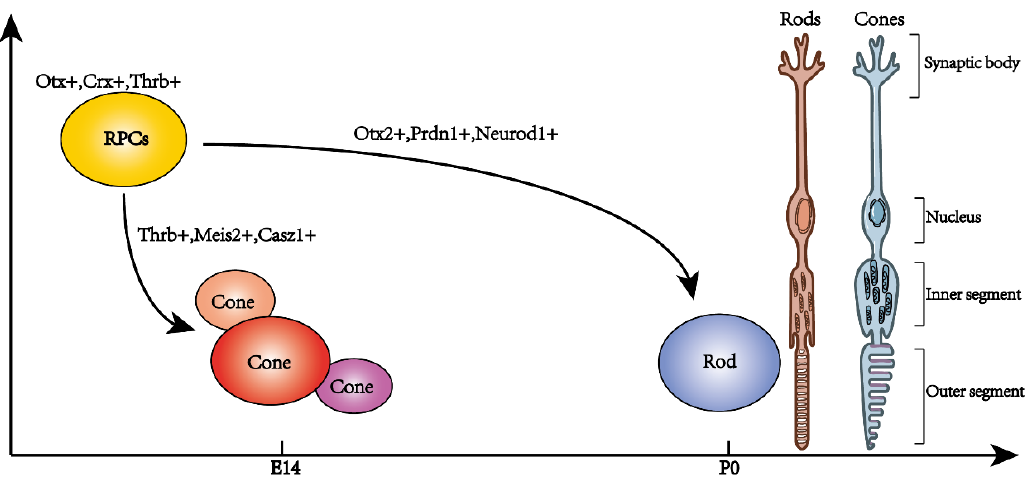
Figure 1. The developmental process of retinal photoreceptors in mice. RPCs: retinal progenitor cells, Otx + , Crx + , and Thrb + , tended to differentiate into photoreceptors. Three clusters of retinal cones, Thrb + , Meis + , and Casz1 + , were discovered at embryonic 14 days. Retinal rods appeared after birth.